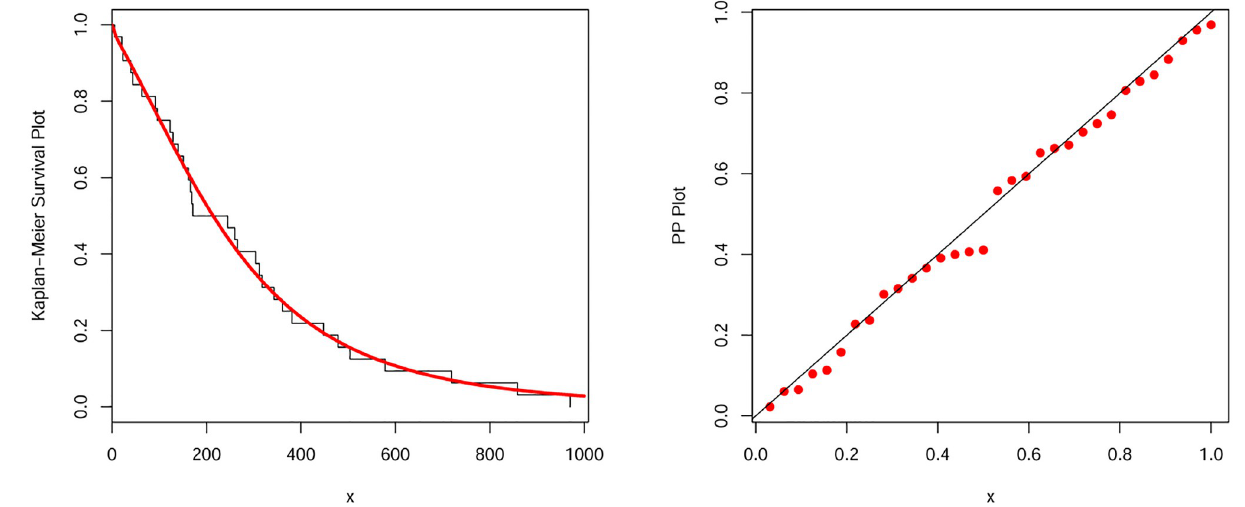
Fig 8. Kaplan Meier survival and PP-plots of the NEHTW distribution for vehicle insurance losses